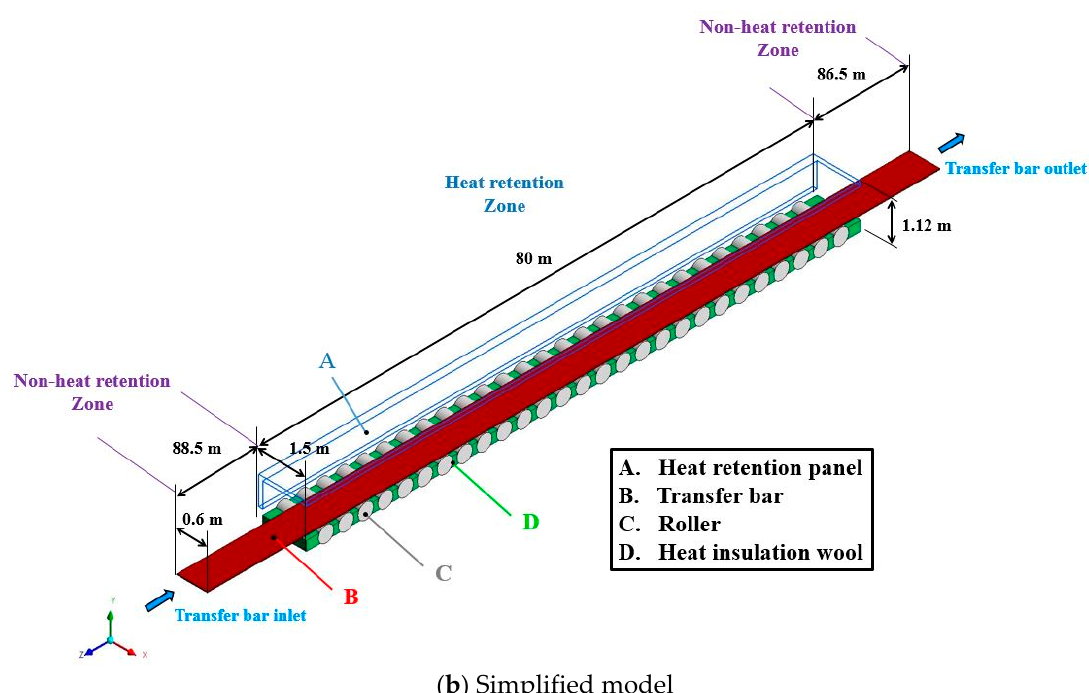
Figure 2. Physical models of the traditional passive heat retention panel.